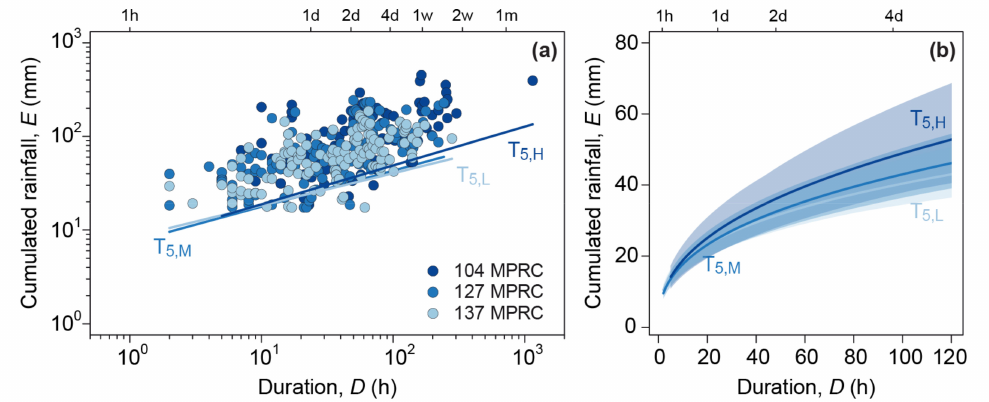
Figure 5. ( a ) Log-log plot with the ED (cumulated event rainfall—duration) conditions that triggered landslides in Slovenia classified according to three classes of mean annual rainfall (MAR) and corresponding 5% ED thresholds (T 5,H , T 5,M , T 5,L ). ( b ) Same thresholds and related uncertainties (shadedareas)intherange1h ≤ D ≤ 120h, inlinearcoordinates. Legend: L,800 mm ≤ MAR ≤ 1300 mm; M, 1300 mm < MAR ≤ 1600 mm; H, 1600 mm < MAR ≤ 4000